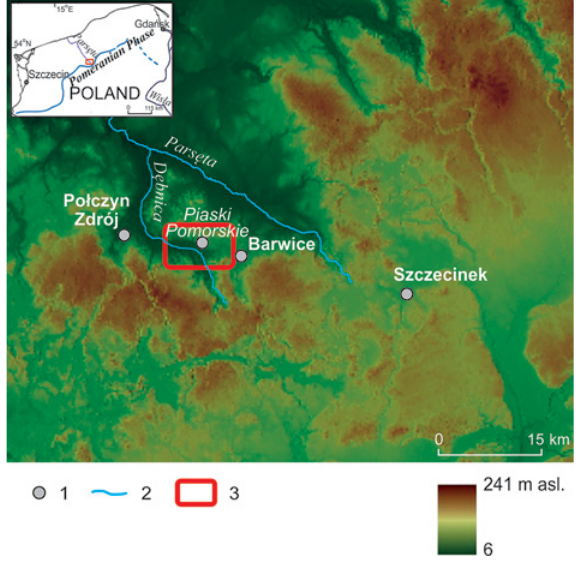
Fig. 1. the location of the research area.